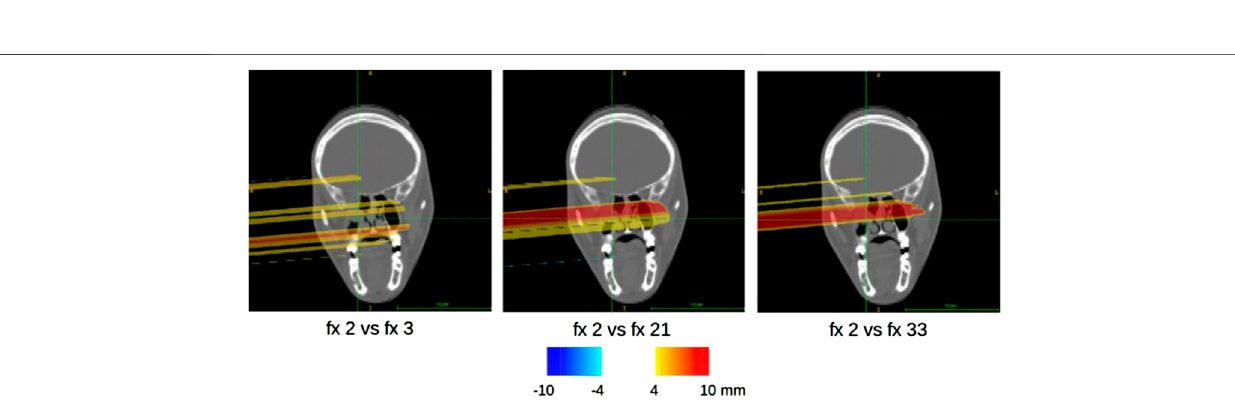
Frontiers in Physics |